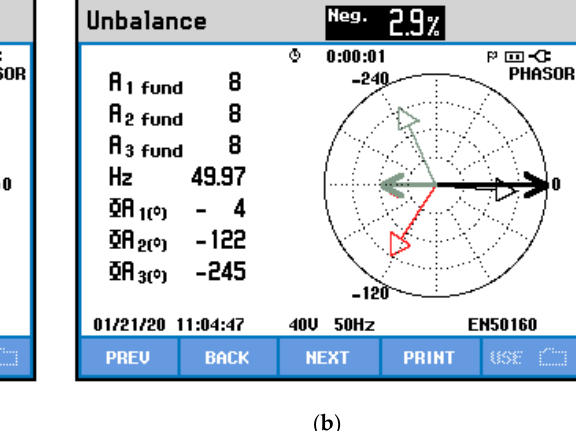
( b ) Figure 21. Harmonic contents value of the three-phase currents at the secondary windings of the V/V transformer (when two load sections are loaded): ( a ) before compensation; ( b ) after compensation. Figure 22 shows the phasors diagram and the unbalance ratio (NSC ratio) of the three-phase currents at the secondary of the V/V transformer. The unbalance ratio before compensation is close to 46.8%, as shown in Figure 22a. The phasors diagram, in this case, shows three-phase current vectors that have different magnitude values. By considering